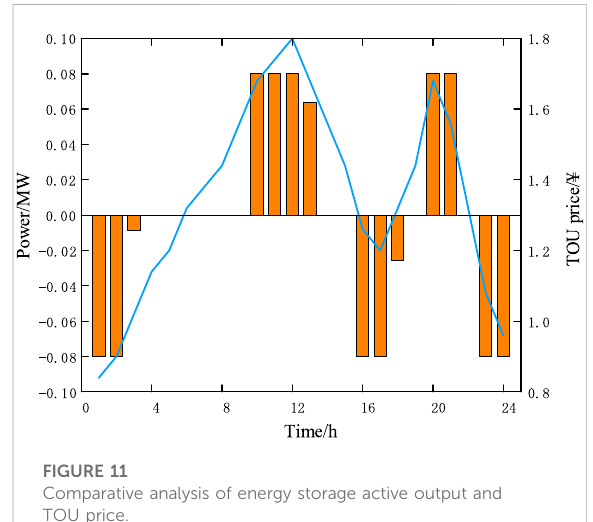
FIGURE 11 Comparative analysis of energy storage active output and TOU price.